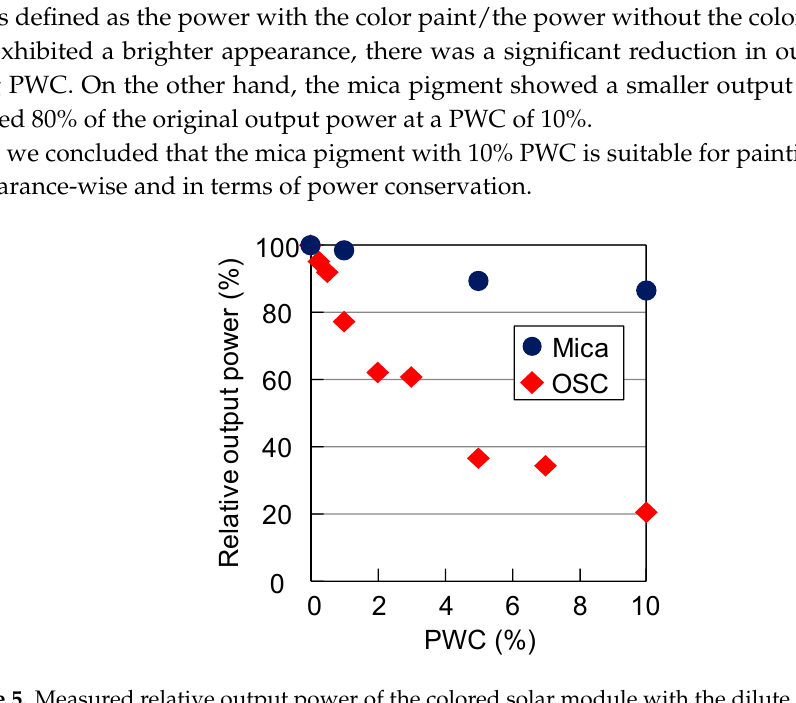
Figure 5. Measured relative output power of the colored solar module with the dilute mica and OSC pigments, as a function of PWC.